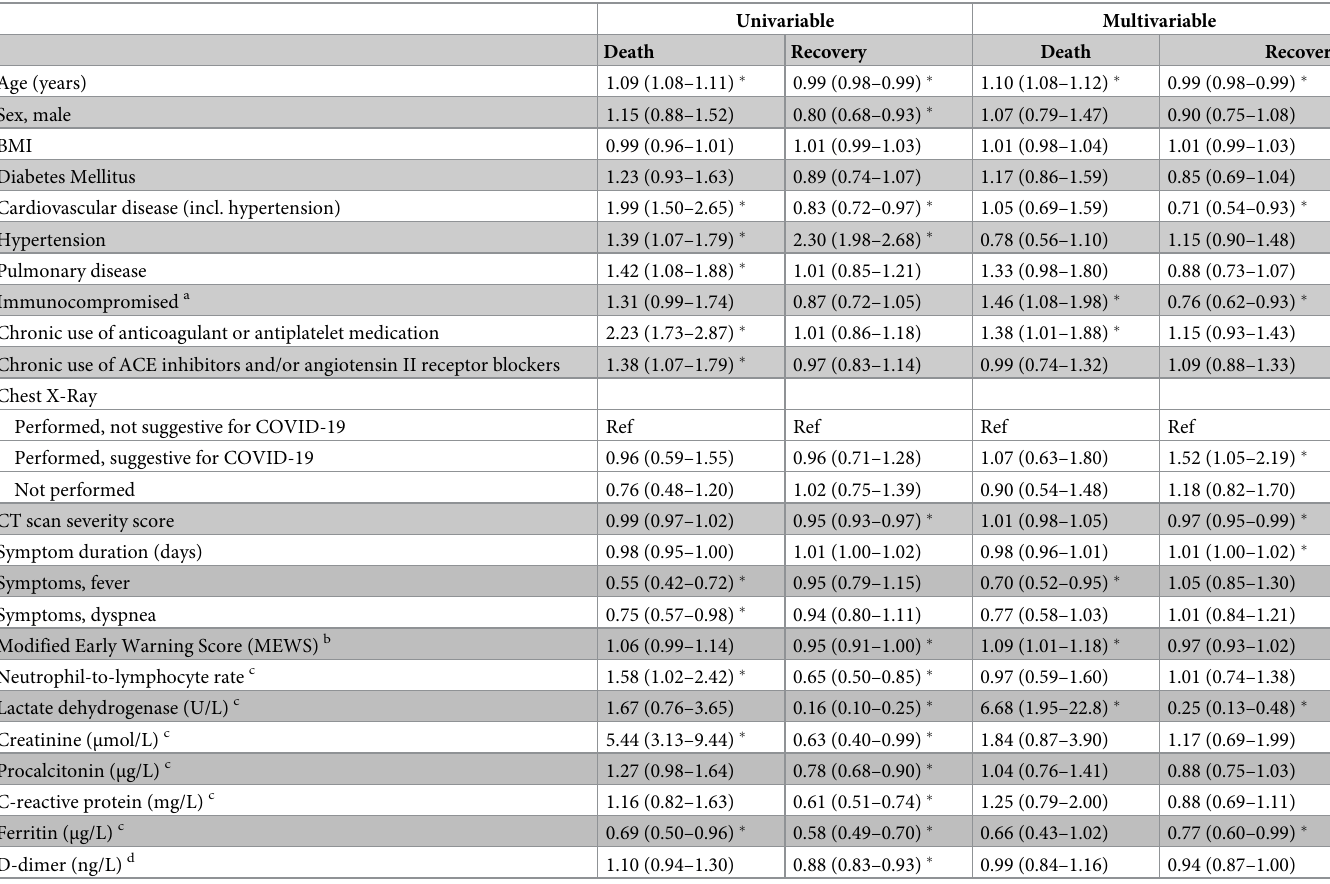
Table 2. Univariable and multivariable cause-specific hazard ratios (HR CS ) including 95% confidence intervals for death and